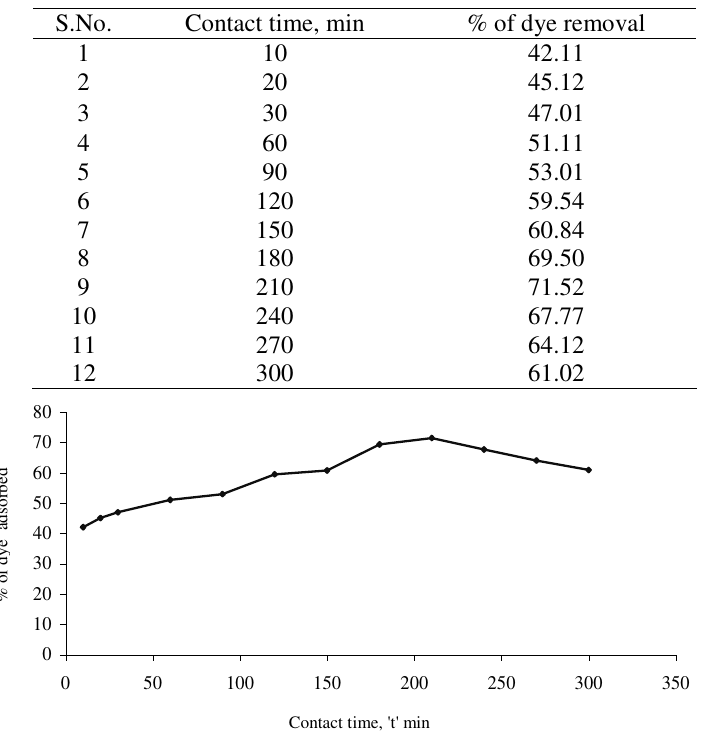
Table 2. Effect of equilibration period (Carbon dose: 1.0 g; particle size: 400 µ ; contact time: 5 h; pH 7.0)